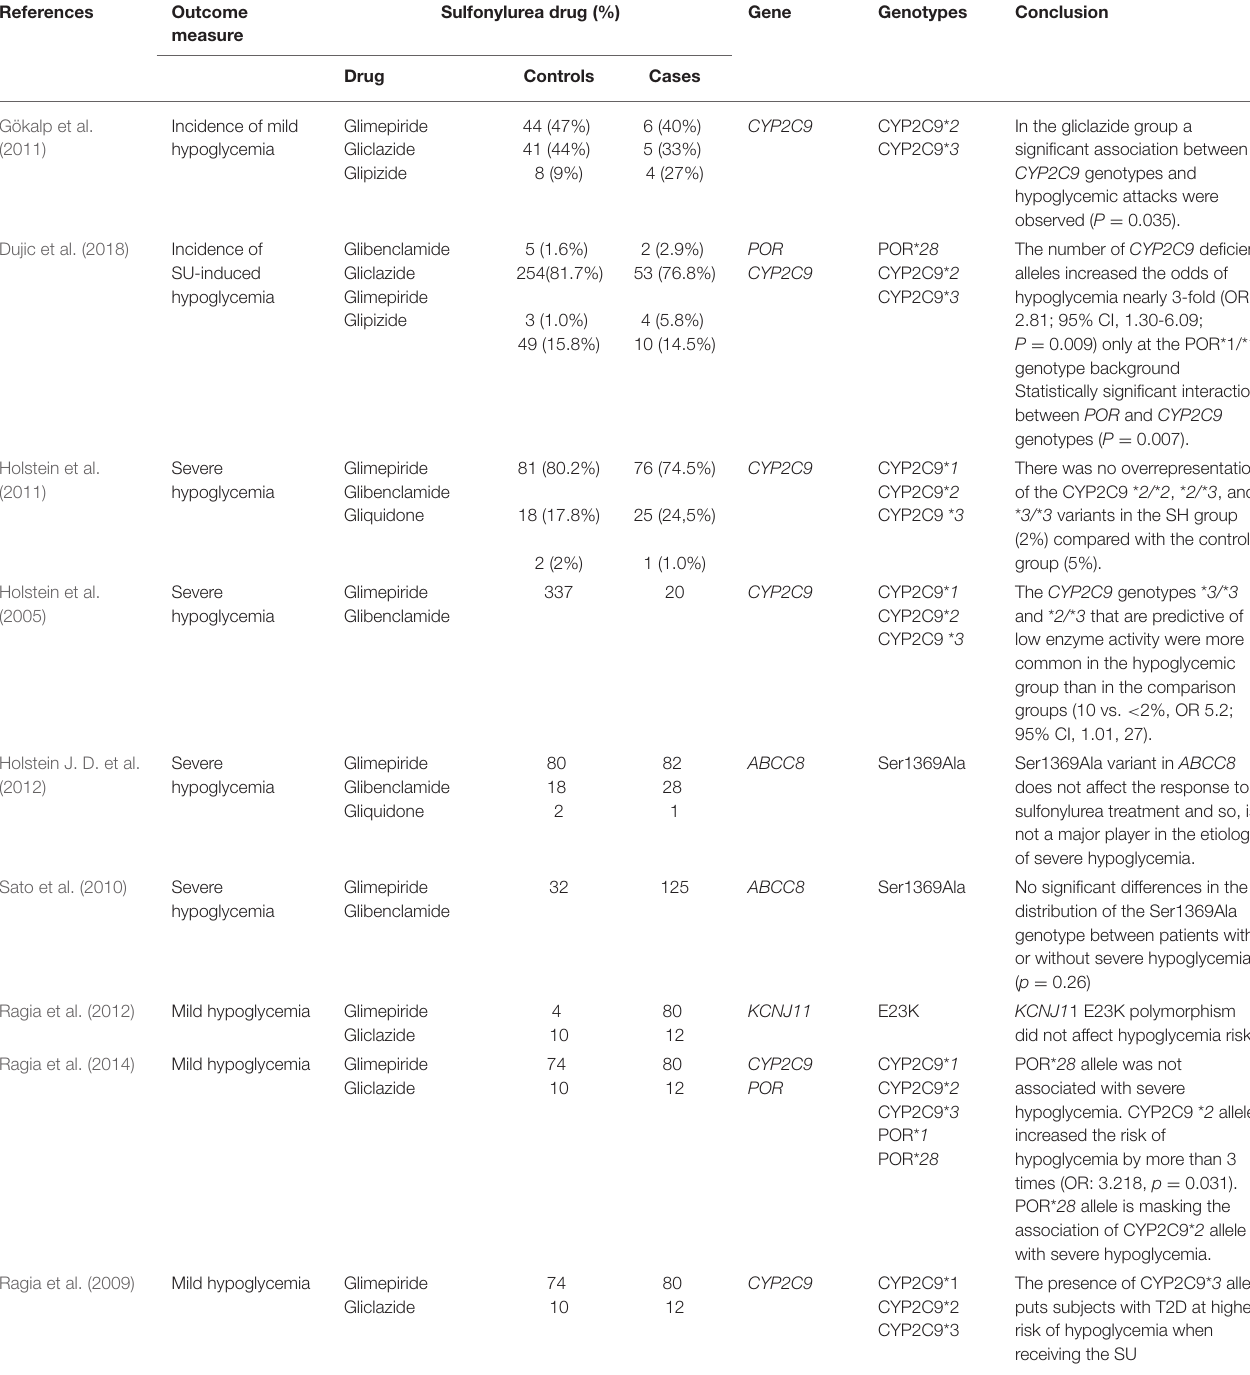
TABLE 4 | Association between sulfonylureas and selected SNPs for the incidence of